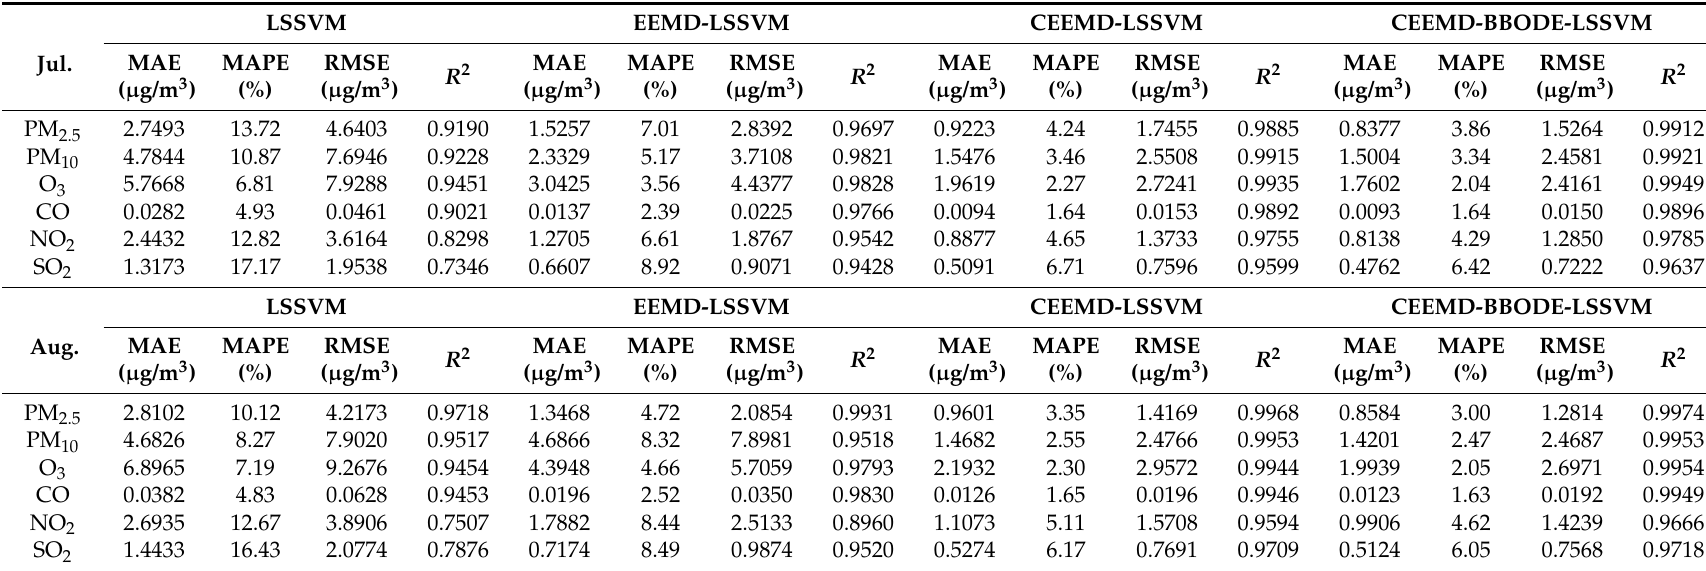
Table 7. Performance evaluations of all forecasting models for air pollutants in July and